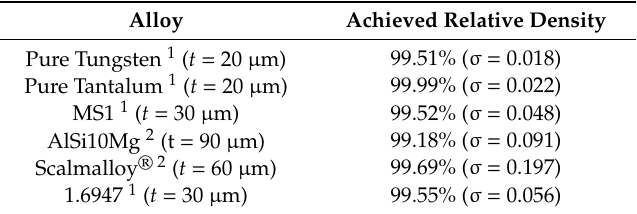
Table 1. The approach was successfully tested for the initial development of process parameters for the following alloys ( t : layer thickness). Results measured by the Archimedean principle according to DIN-EN-ISO-3369 [38].